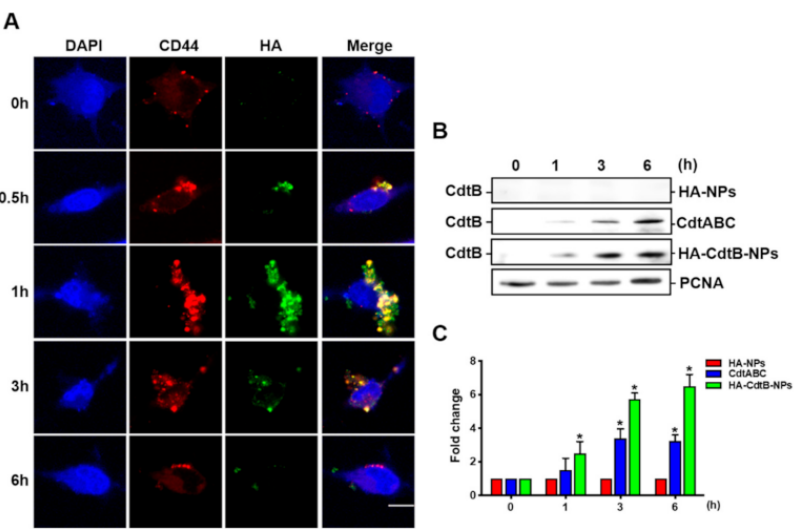
Figure 3. Delivery of HA-CdtB-NPs into PCa cells. ( A ) PC3-KD cells were treated with HA-CdtB-NPs- GFP for 0, 0.5, 1, 3, and 6 h. The colocalization of CD44 and HA on the cell membrane was observed. Scale, 10 µ m. ( B ) PC3-KD cells were exposed to 100 nM HA-NPs, CDT holotoxin, and HA-CdtB-NPs, then incubated for the indicated times. The nuclear fraction from cell lysates was prepared and CdtB in the nucleus was analyzed by Western blotting. Proliferating cell nuclear antigen (PCNA) was used as a loading control for nuclear protein. ( C ) The expression of CdtB in the nucleus was quantified for each time point. Statistical significance was evaluated using one-way ANOVA with post hoc test (* p <